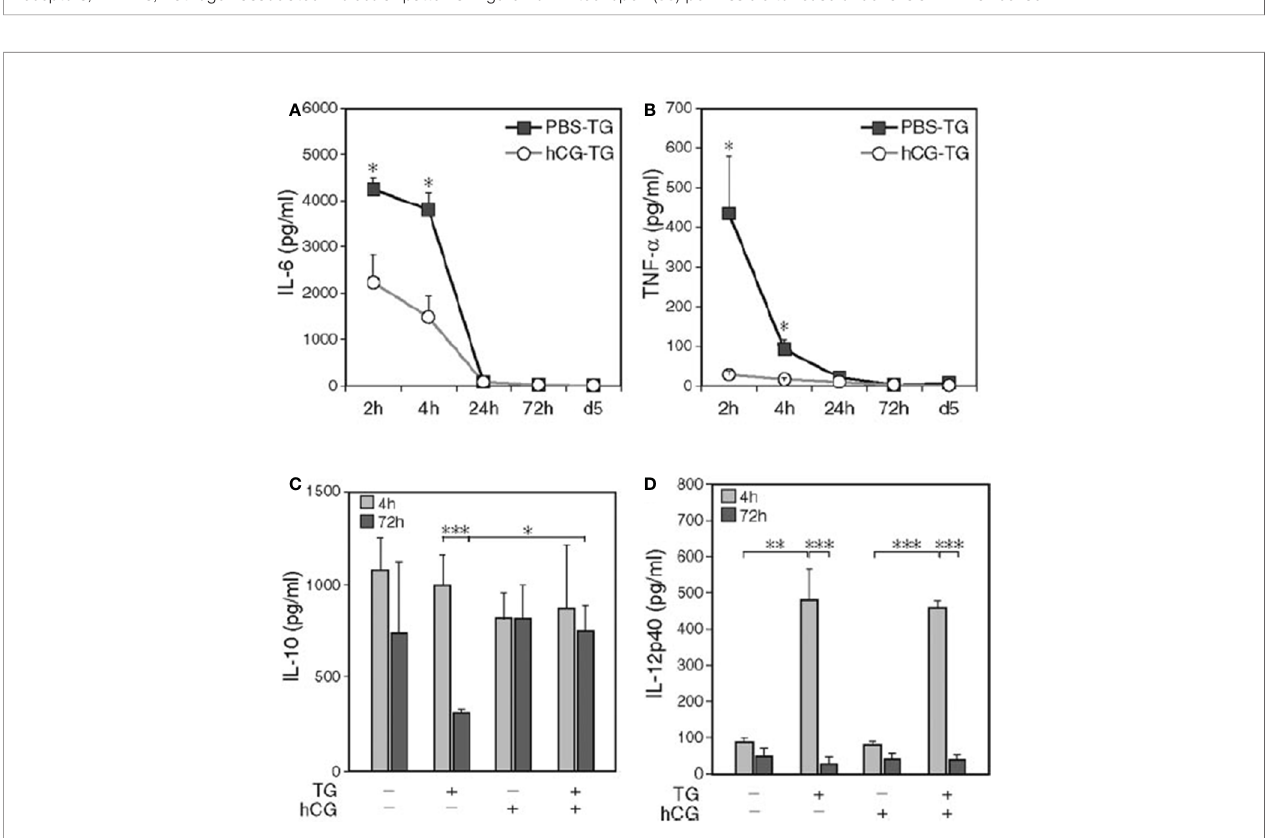
FIGURE 8 | hCG pre-treatment reduces the level of IL-6 and TNF- a in peritoneal lavage fl uid (77). C57BL/6 mice were injected intraperitoneally with hCG or PBS. One hour later, TG was intraperitoneally injected after 2 h, 4 h, 24 h (Day 1), and 72 h (Day 3). On Day 5, mice were sacri fi ced, and peritoneal lavage fl uid was collected, and cytokine measured. Upon hCG pretreatment of TG-induced peritonitis, decreased IL-6 (A) and TNF- a levels (B) at 2 h and 4 h and a higher IL-10 level (C) at 72 h were observed, whereas IL-12p40 remained unchanged (D) ; n = 15. Kinetic data depicted are from a separate representative experiment with fi ve mice per group (A, B) . *P < 0.05; **P < 0.01; ***P <